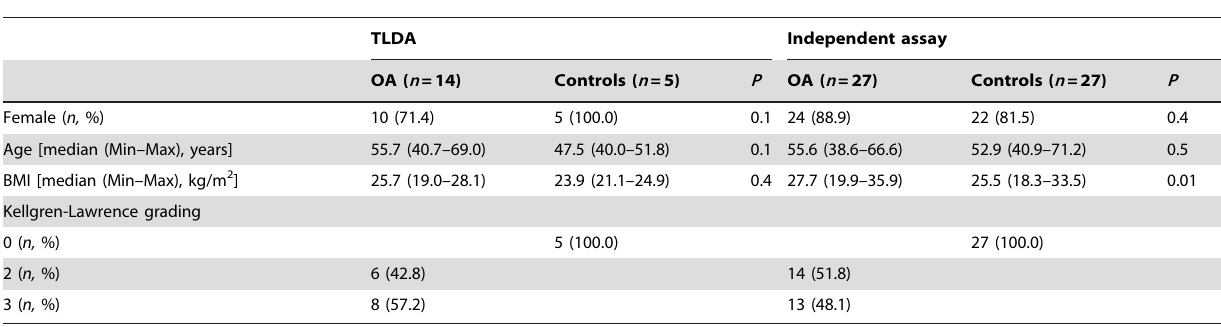
Table.1 Characteristics of the study